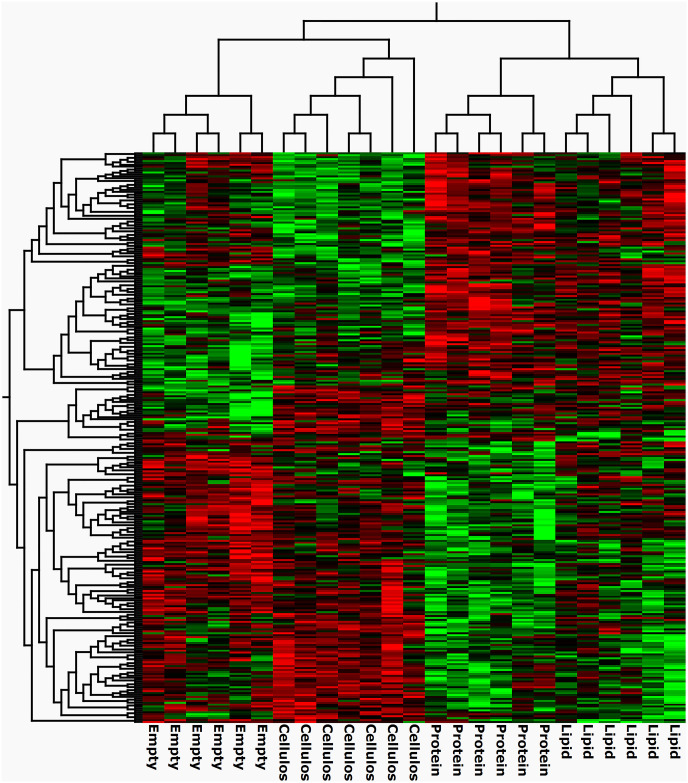
Nutrient and physical stimuli modulates the transcriptome in Segment 1.Hierarchical clustering of differentially expressed (p < 0.01) genes using multi/group comparison embedded in the Qlucore omics explorer. N = 6 for intestines fed with protein or lipid or empty intestines, n = 7 for intestines fed with cellulose.